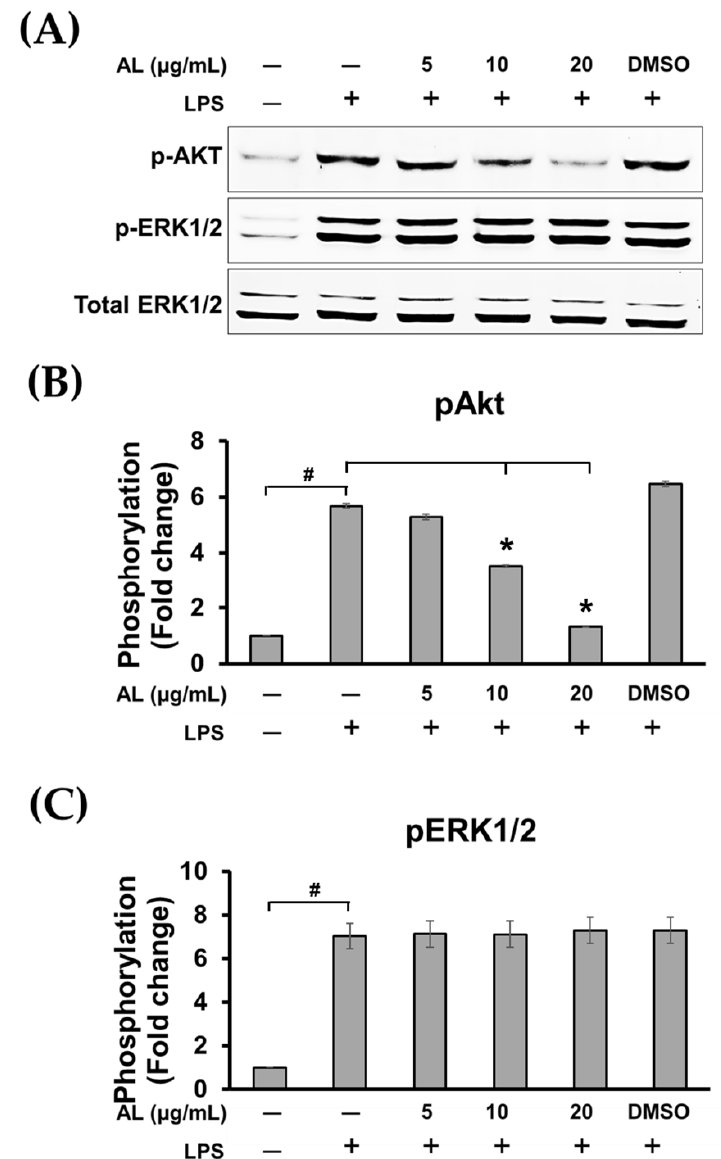
Figure 7. ( A ) Western blot analysis for the inhibitory e ff ects of AL extract on the phosphorylation of Akt and ERK1 / 2 after cells were incubated with various concentrations of AL extract (5, 10, and 20 µ g / mL) for 3 h before stimulation with LPS, total ERK1 / 2 was detected and used as an internal control; ( B ) quantitative analysis for Akt phosphorylation at Ser473; ( C ) quantitative analysis for ERK1 / 2 phosphorylation. Data are representatives of three replicates and shown as mean ± SD; # p < 0.05 (compared to the untreated control) or * p < 0.05 (compared to the LPS-treated group).